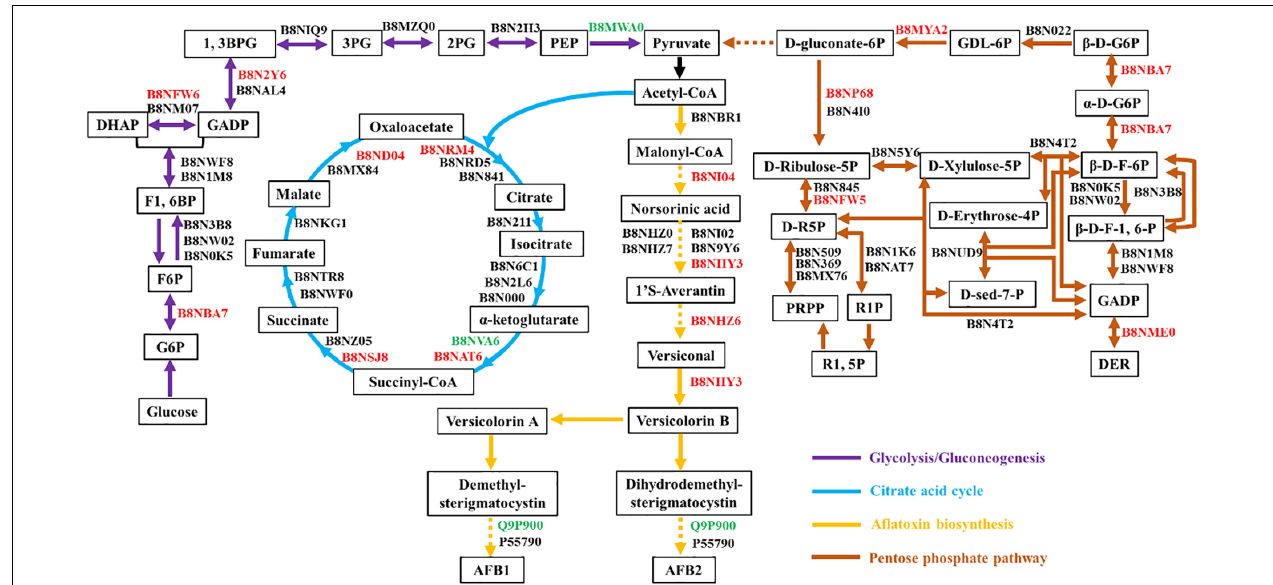
FIGURE 4 | Carbohydrate metabolic pathway annotation for quantified proteins. Glycolysis, the citric acid cycle, aflatoxin biosynthesis, and the pentose phosphate pathway are represented with purple, blue, yellow, and brown lines, respectively. All quantified proteins are marked in black [no significant change (0.67<FC<1.50)], red [up-regulated (FC ≥ 1.50)], or green [down-regulated (FC ≤ 0.67)] according to the fold change between high- and low-yield A. flavus